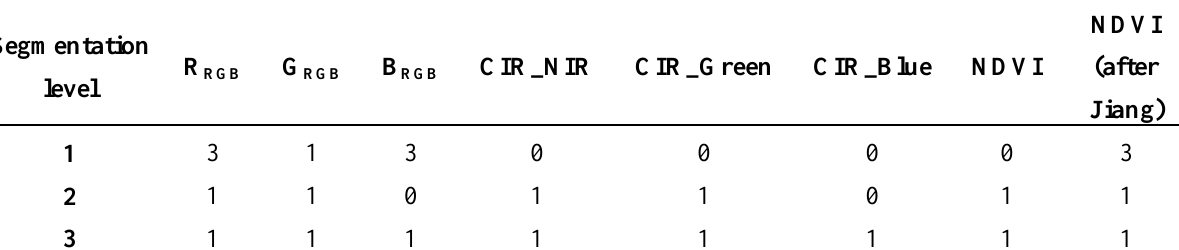
Table 4. Layer weights assigned in the current